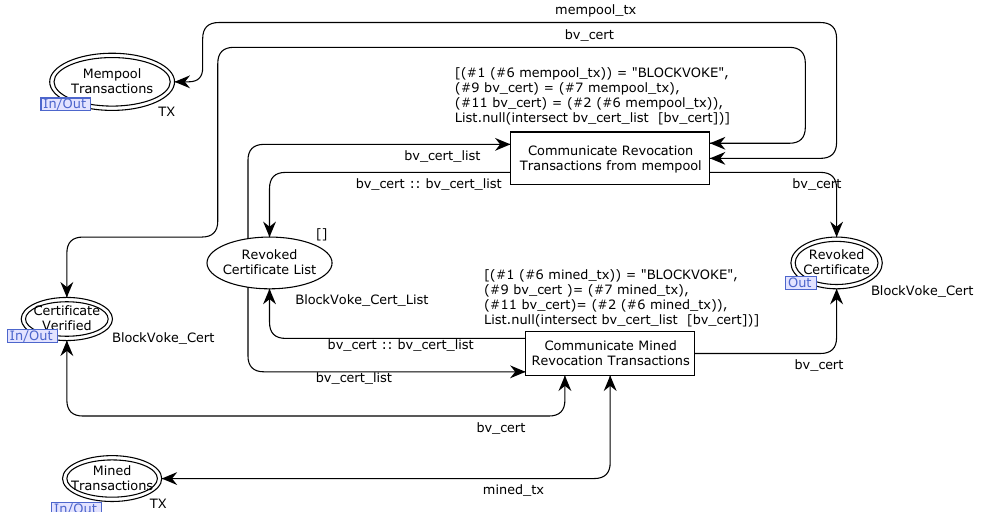
Figure 17. ‘Mark Certificate as Revoked’ sub-module of the BlockVoke CPN model.